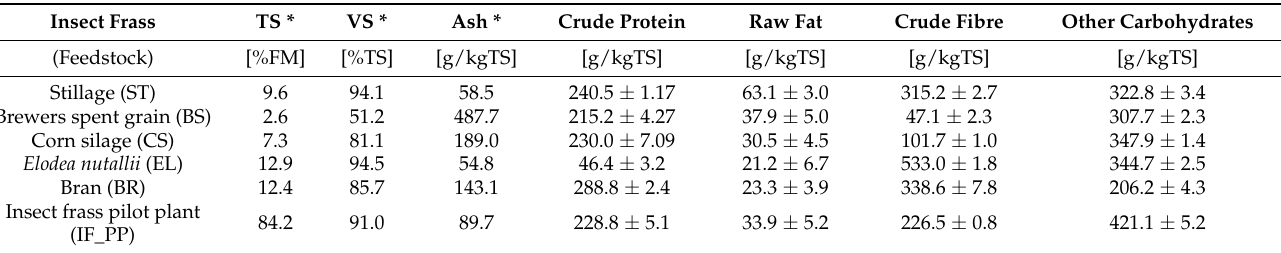
Table 1. Insect frass sample material